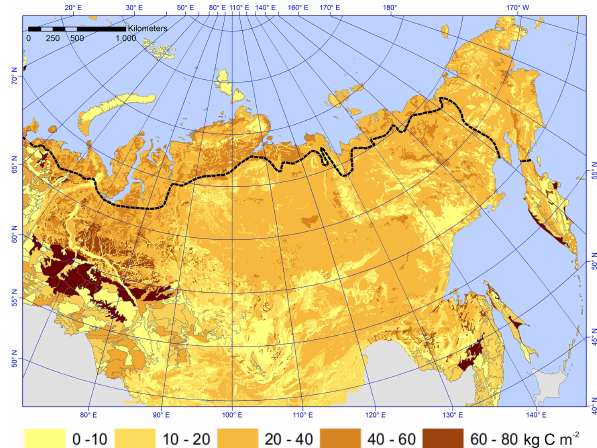
Figure 7. Spatial distribution of the soil organic carbon contents in Russian Federation. The dashed line illustrates the tree limit. Based on Hugelius et al. (2013a), Stolbovoi (2002b) and Brown et al.